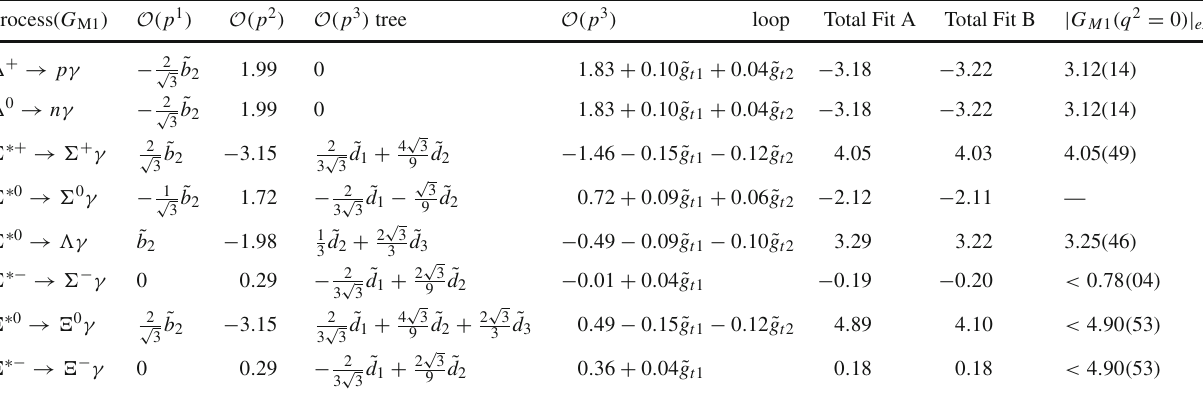
Table 3 The decuplet to octet baryon transition G M 1 ( q 2 = 0 ) to the next-to-next-to-leading order (in unit of 1). Actually, we use the branching ratios in PDG to extract the corresponding transition | G M 1 ( q 2 = 0 ) | exp